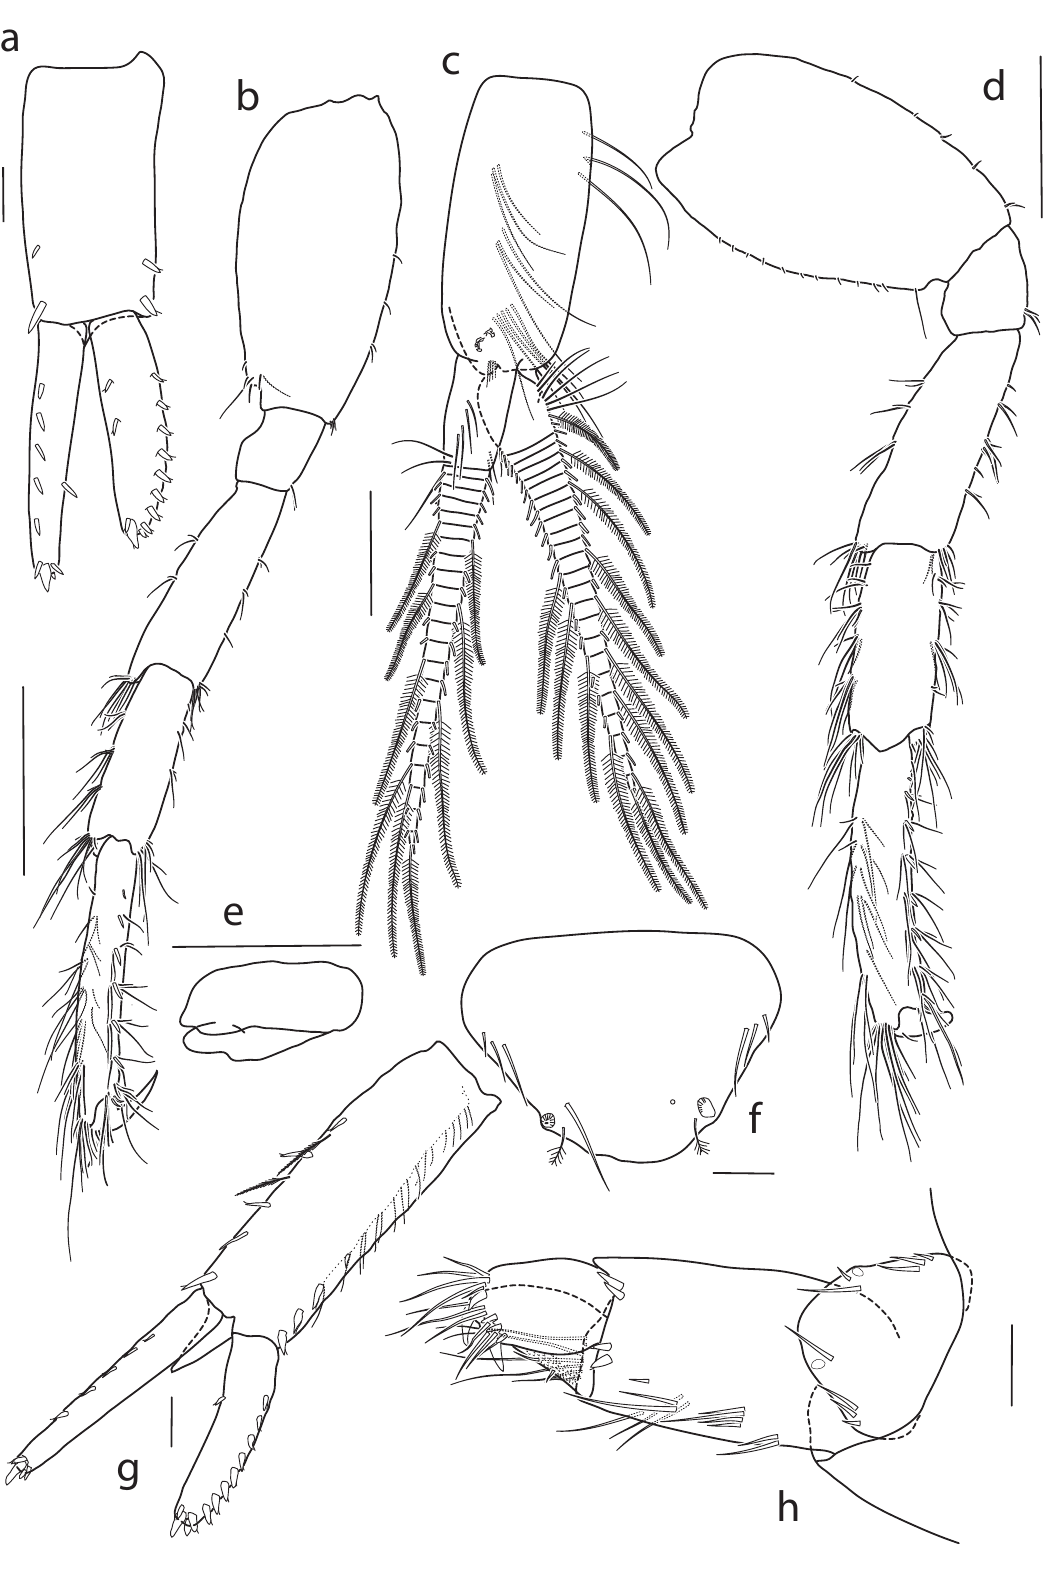
Fig. 6. Sunamphitoe femorata (Krøyer, 1845), ♂, 12 mm (ZMB 34100). a . Uropod 2. b . Pereopod 6. c . Pleopod 1. d . Right pereopod 7. e . Coxa 6. f . Telson. g . Uropod 1. h . Telson and uropod 3. Scale bars: a, c, f–h = 100 µm; b, d–e = 500